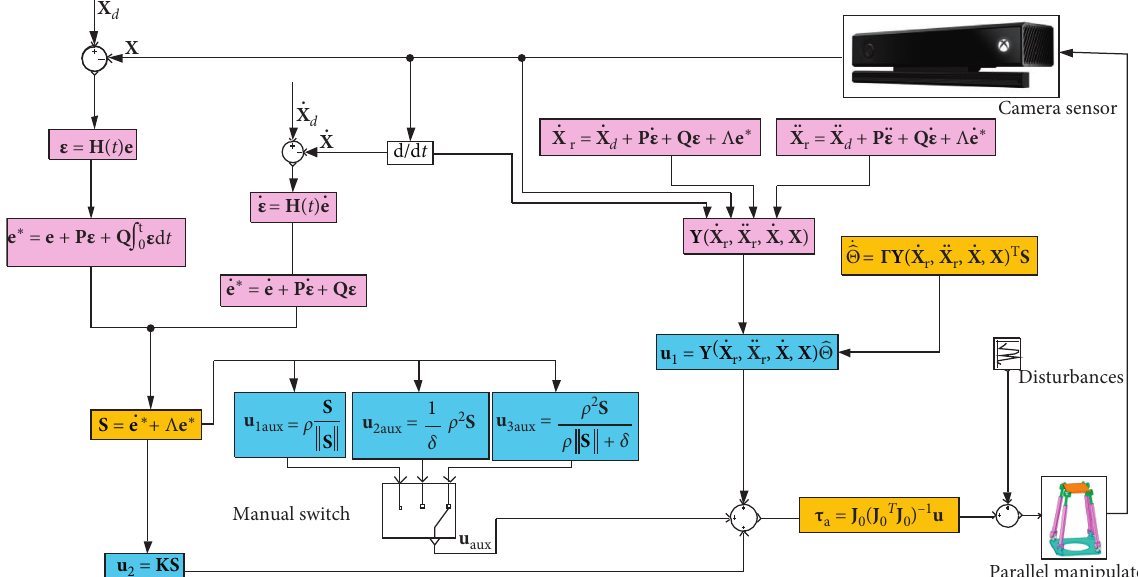
Figure 4: The proposed three adaptive robust synchronous control diagram of parallel